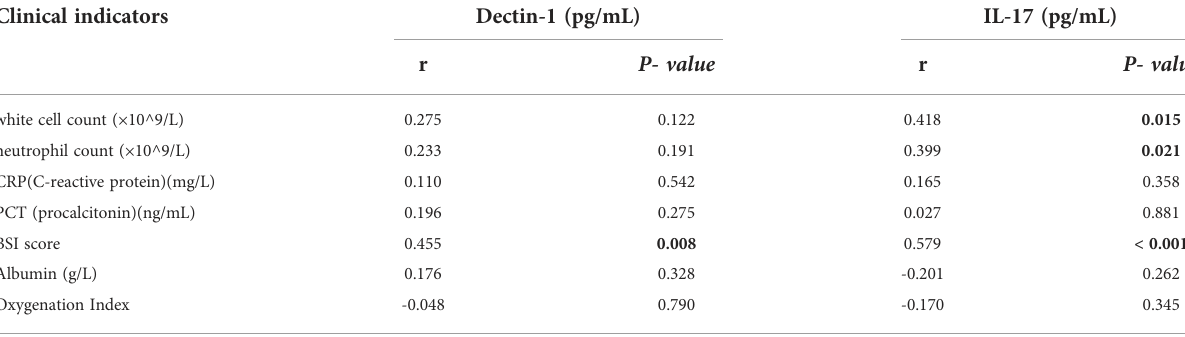
TABLE 2 Correlation between plasma Dectin-1/IL-17 and various clinical indicators in IPA combined with bronchiectasis group. Clinical